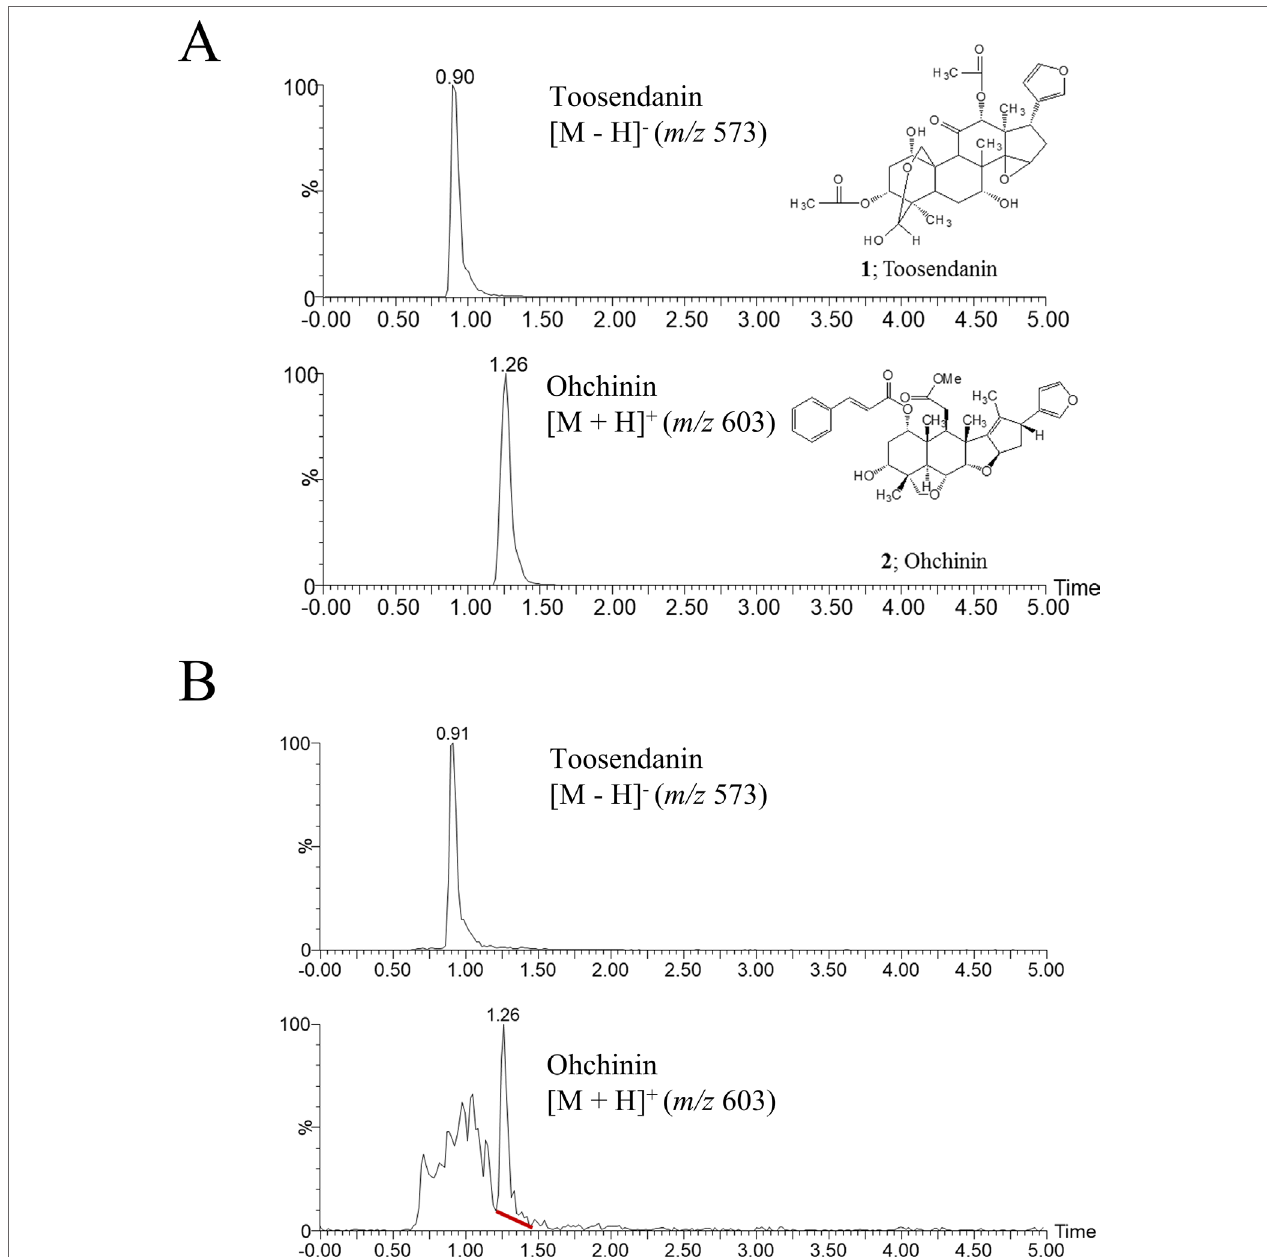
FIGURE 1 | UPLC-MS chromatograms of toosendanin, Ohchinin, and Melia Fructus (MF) ethanol extract. (A) The chemical structures of toosendanin (TSN) and Ohchinin (OCN) and the UPLC-MS chromatograms of TNS (upper panel) and OCN (lower panel) standards in single ion monitoring (SIM) mode. (B) UPLC-MS chromatograms for m/z 573 (upper panel) and m/z 603 (lower panel) ions in MF ethanol